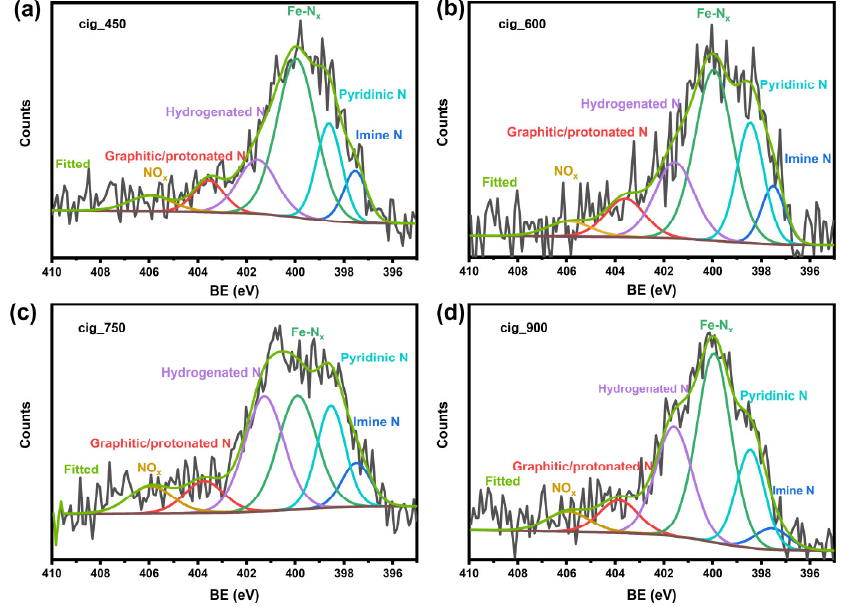
Figure 4. XPS deconvolution of N 1s peak of ( a ) cig_450, ( b ) cig_600, ( c ) cig_750 and ( d ) cig_900 with raw data.